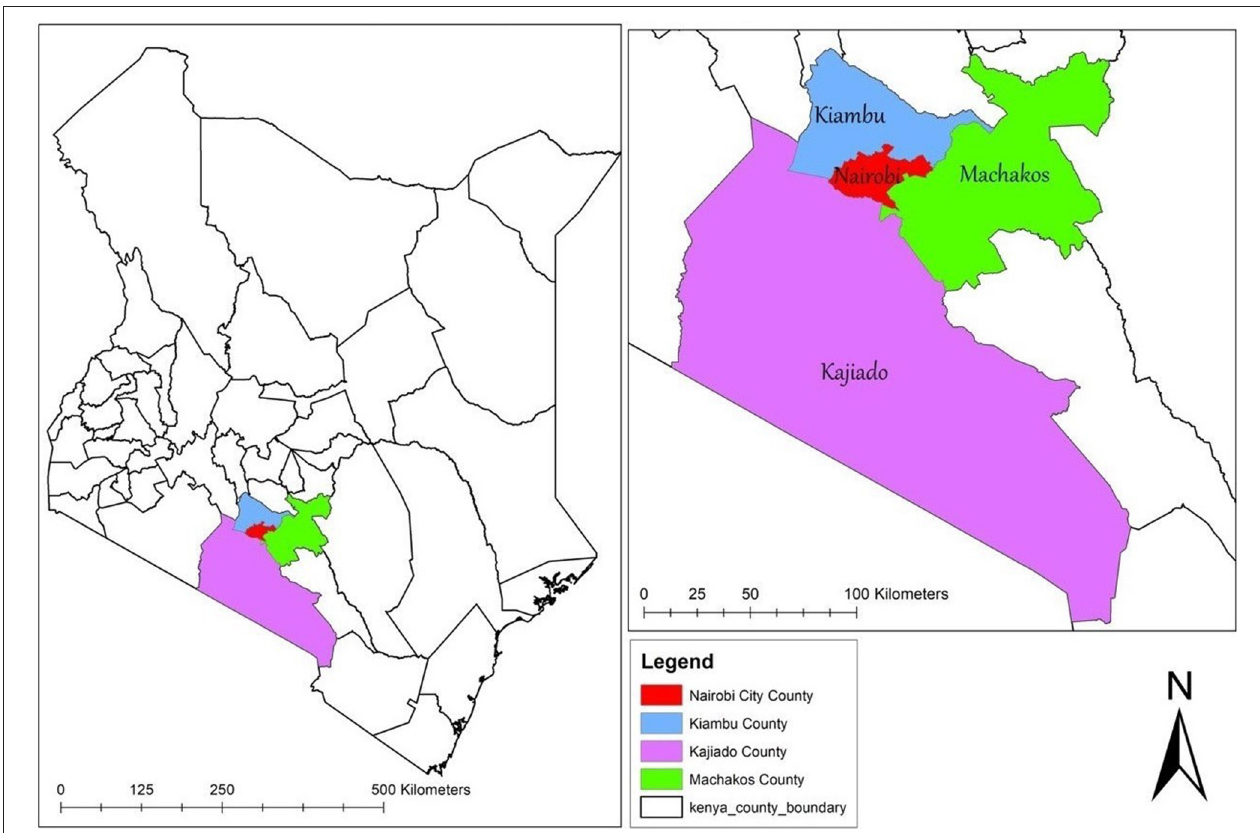
FIGURE 2 | Map showing the study catchment area. The map was created by the author by downloading shapefiles from World Resource Institute (https://www.wri. org/resources/data-sets/kenya-gis-data)—an open source website. The data was then exported to ArcGIS V.10.5 (https://desktop.arcgis.com/en/)—a free mapping, analysis and data storage system used for creating and sharing maps and other geographic content, to create the current